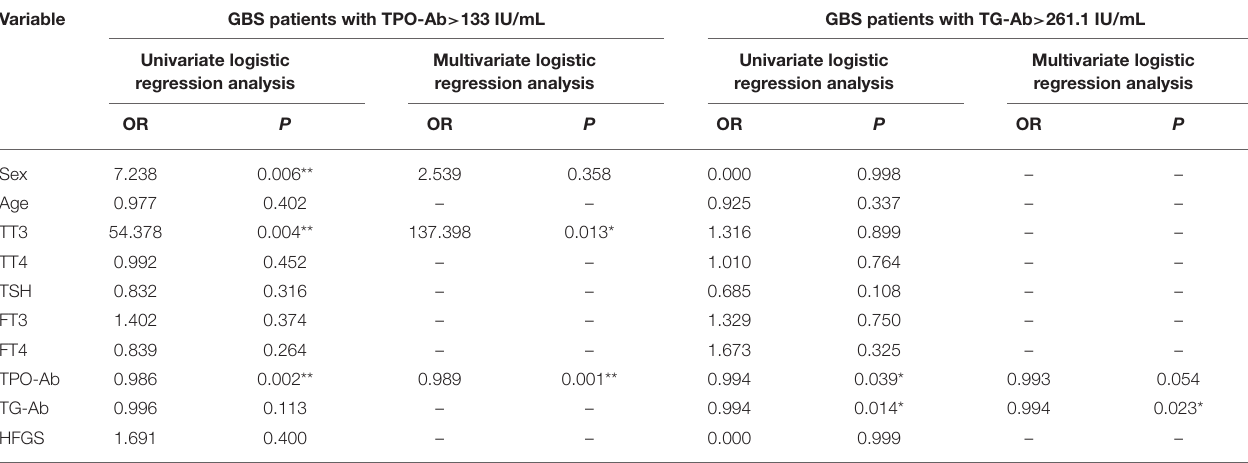
TABLE 5 | Logistic regression analysis of risk factors for GBS patients with TPO-Ab > 133 IU/mL or TG-Ab > 261.1 IU/mL. Variable GBS patients with TPO-Ab > 133